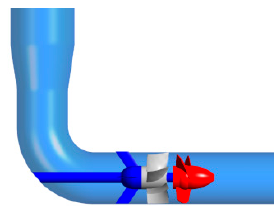
Figure 2. Three-dimensional structure